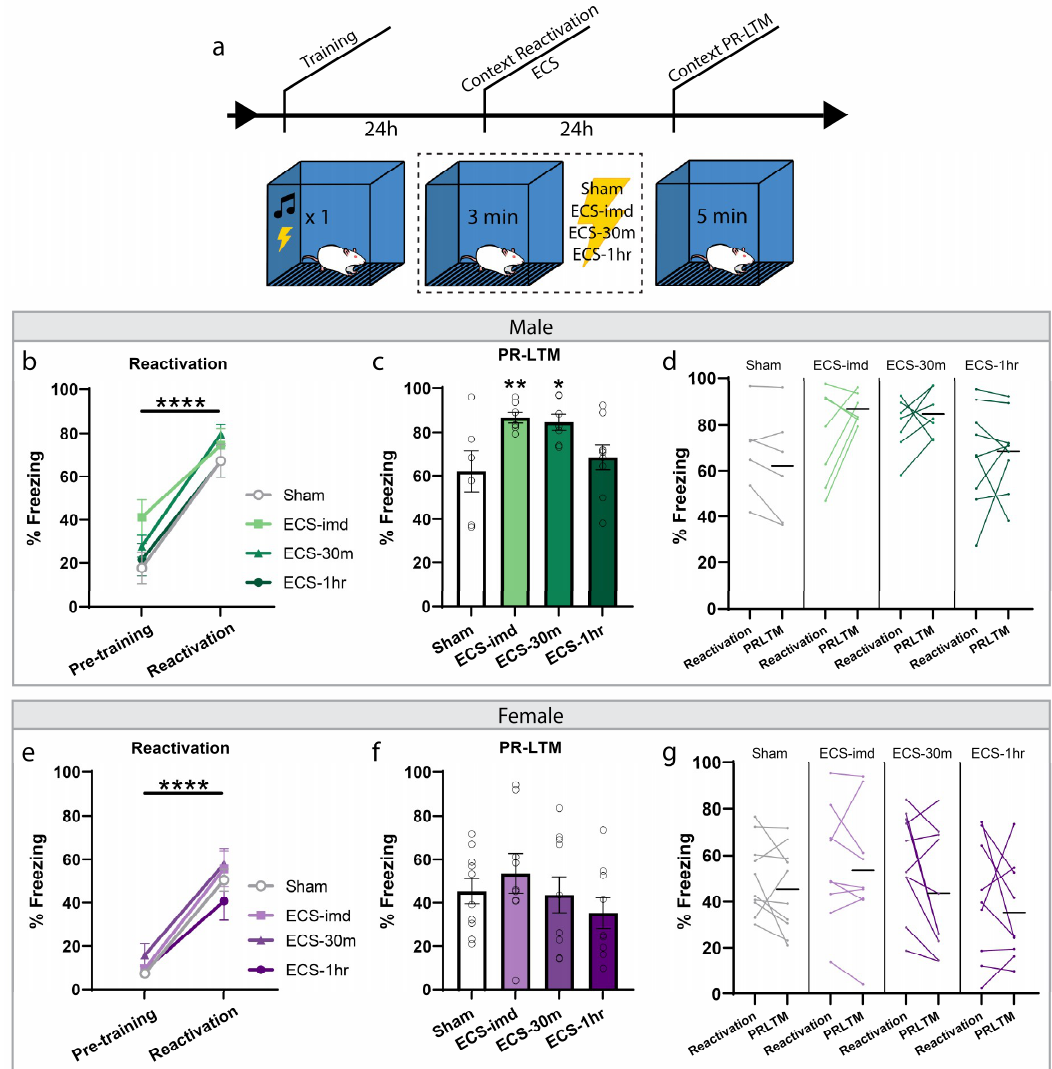
Figure 2. ECS delivery after contextual reactivation does not disrupt reconsolidation of a contextual fear memory. ( a ) Schematic outline of experimental procedures for the context-ECS experiments. All